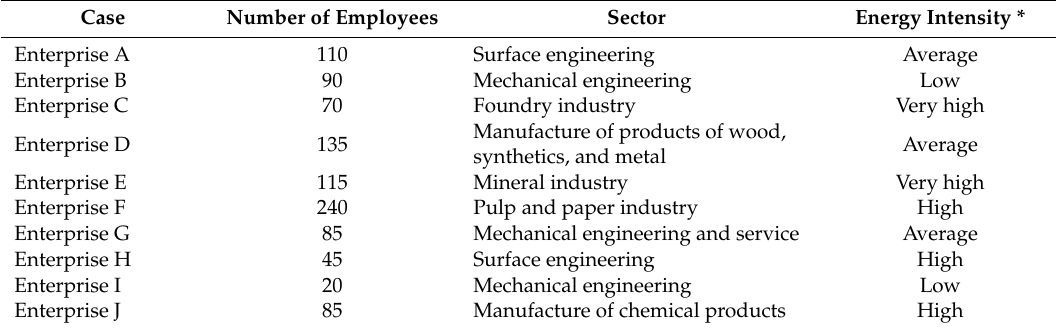
Table 1. List of enterprises participating in the case studies.